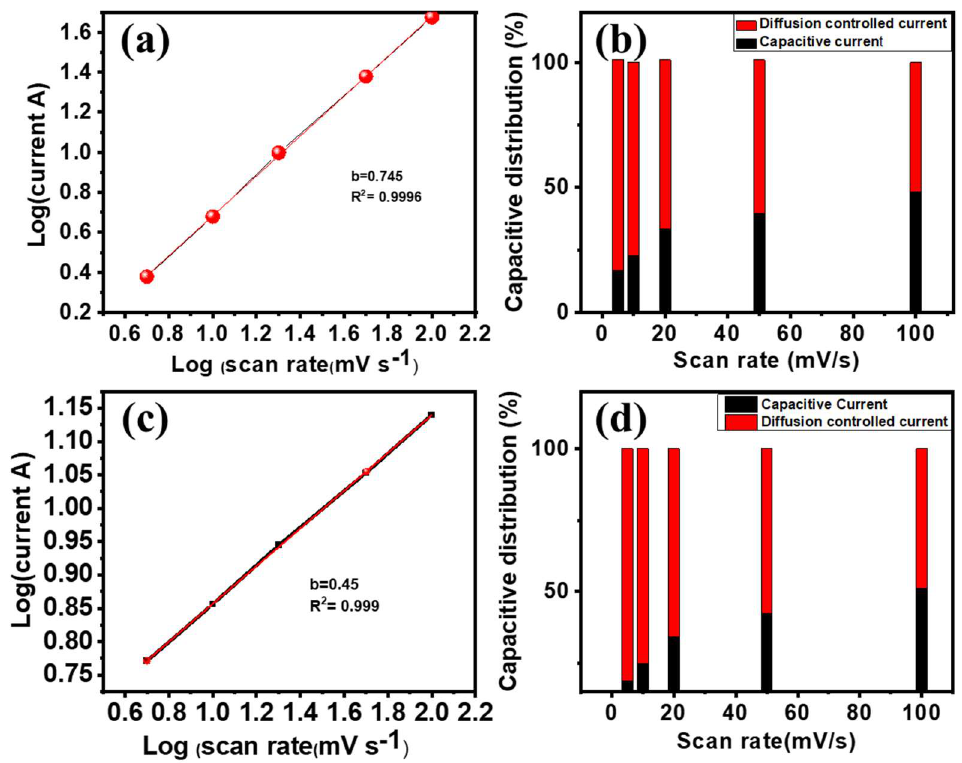
Figure A3. ( a , c ) Plot of current vs. scan rate in log-scale to calculate the b-value, ( b , d ) the plot of capacitive and diffusion-controlled current contributions with scan rates corresponding to Fe 2 O 3 and Co 3 O 4 , respectively.